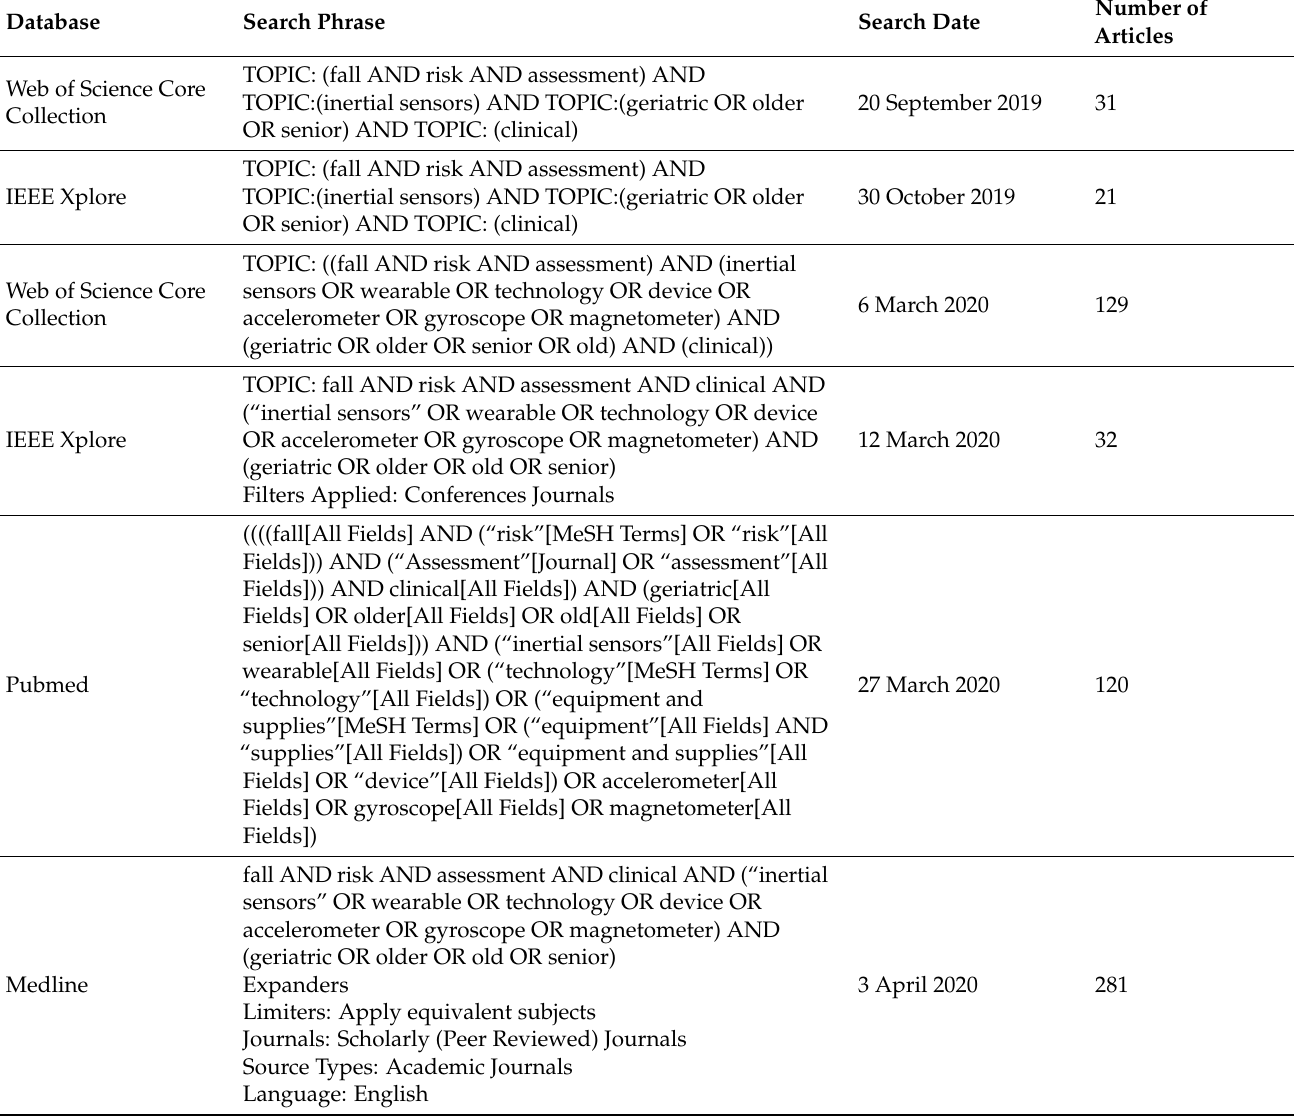
Table 2. An overview of databases, search phrases used during article retrieval, and information on search dates. The numbers indicate the number of identified articles in each